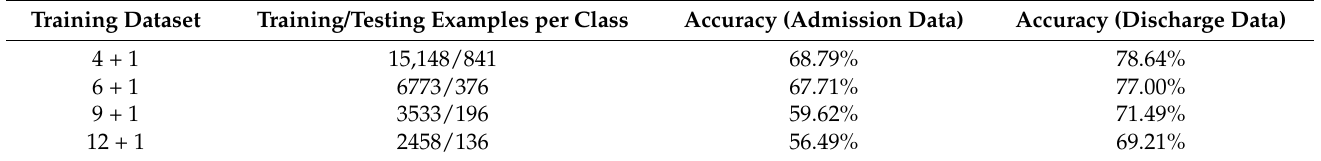
Table 5. Overview of the main classification results for the different dataset variations.